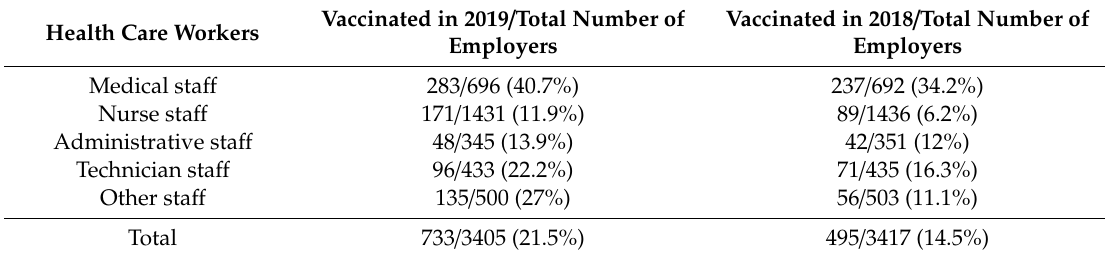
Table 1. Comparison between vaccination coverage rate for healthcare workers, 2018 versus